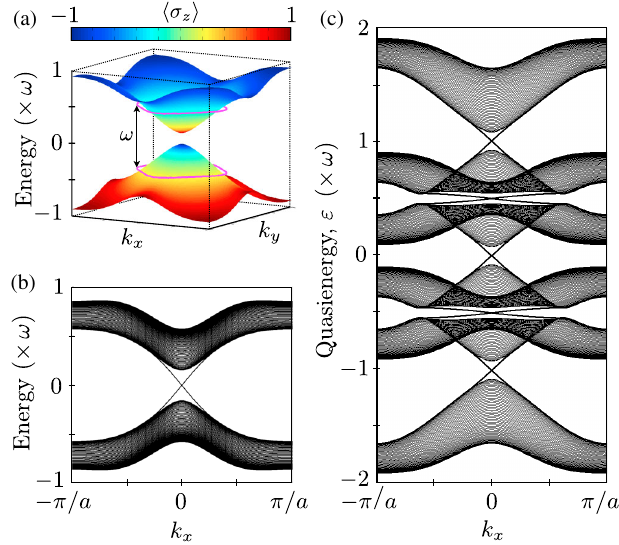
FIG. 6. Anomalous edge states in a weakly driven two-band given by Eqs. (20) and (21). The system, with Hamiltonian H 0 ¼ (cid:4) 1 . Chern numbers of the unperturbed bands are C 0 with periodic boundary conditions, showing (a) Spectrum of H 0 the resonance curve (purple line) in the valence and conduction i for the corresponding bands. The color scheme indicates h (cid:3) z for a cylindrical eigenstates in the two bands. (b) Spectrum of H 0 geometry, with periodic boundary conditions in the x direction and open boundary conditions in the y direction. (c) Spectrum of the truncated Floquet Hamiltonian [Eq. (18)] in the cylindrical geometry. The isolated bands at the top and bottom of the figure do not participate in any resonances and are nearly identical to . The Floquet bands have zero Chern the original bands of H 0 numbers, while edge states traverse both gaps, centered around " ¼ 0 and " ¼ (cid:1)=T . The parameters used are J=(cid:5) ¼ b=(cid:5) ¼ =(cid:5) ¼ 1 , and (cid:2) =! ¼ 0 : 07 1 : 5 , a=(cid:5) ¼ 4 , (cid:2) 0 0